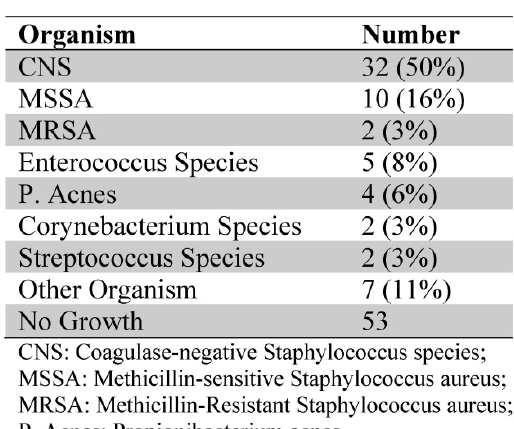
Table 2: Organisms cultured preoperatively or at implant